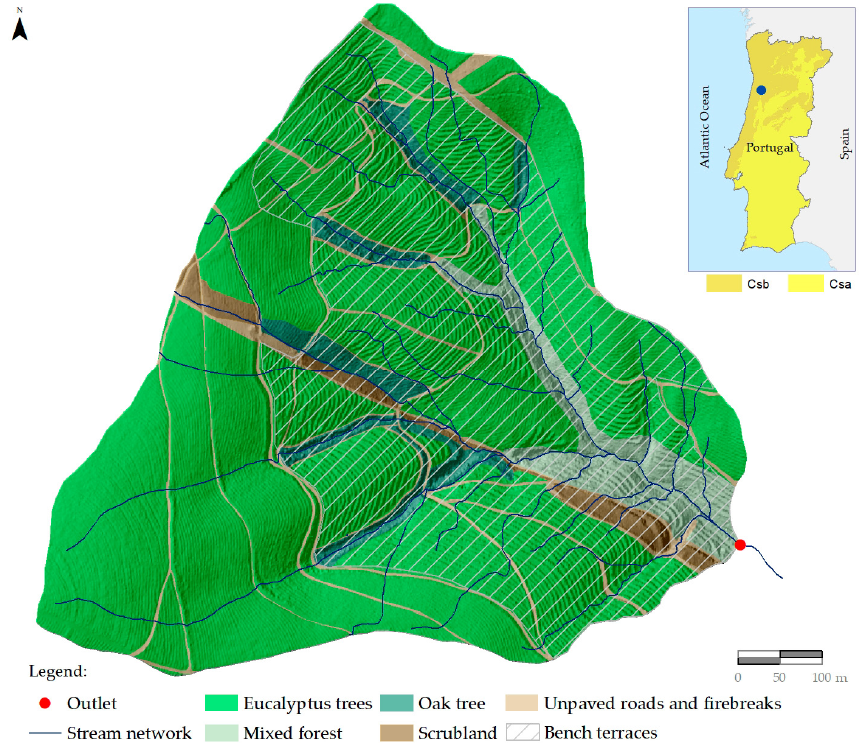
Figure 1. Location of the Braçal experimental catchment. Representation of the main land uses, stream network, topographic surface and area cover by terraces (0.25 m DEM). The catchment registers an average slope ranging from 15% to 27%, as the catchment is partially occupied by bench terraces (identified in Figure 1 with a light grey line). Bench terraces are edified along the steeper parts of the catchment and represent about 59% of the total area, being mostly occupied by eucalypt plantation (72%). On the Braçal experimental catchment upland bench terraces, more precisely reverse sloped terraces [12] were edified (Figure 2). These terraces average 2 m in length and 2 m in height.